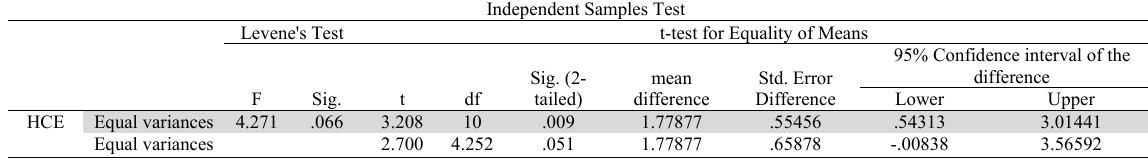
Independent Samples Test